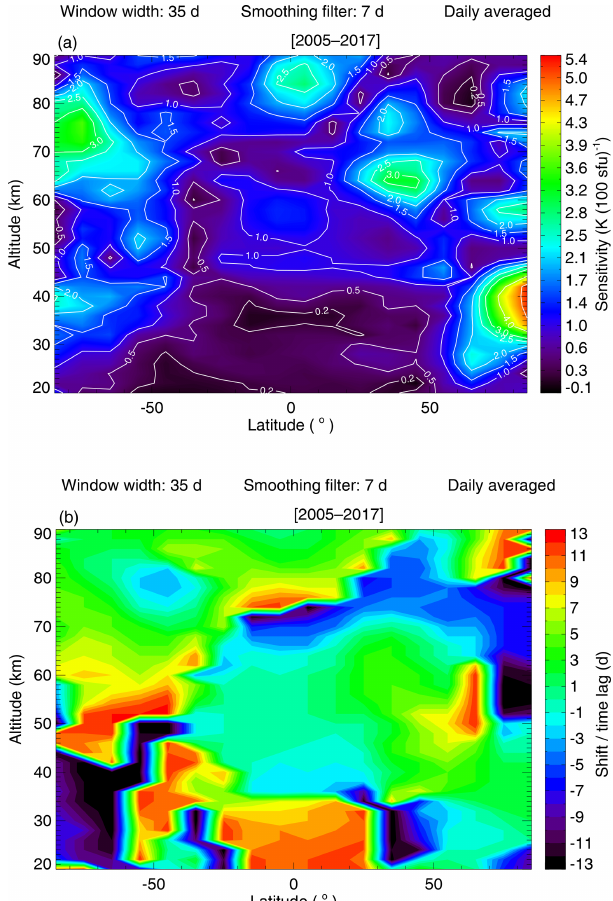
Figure 13. The (a) sensitivity and (b) shift for all latitudes from 85 ◦ S to 85 ◦ N and the altitudes from 20 to 90km, and the analysis year is from 2005 to